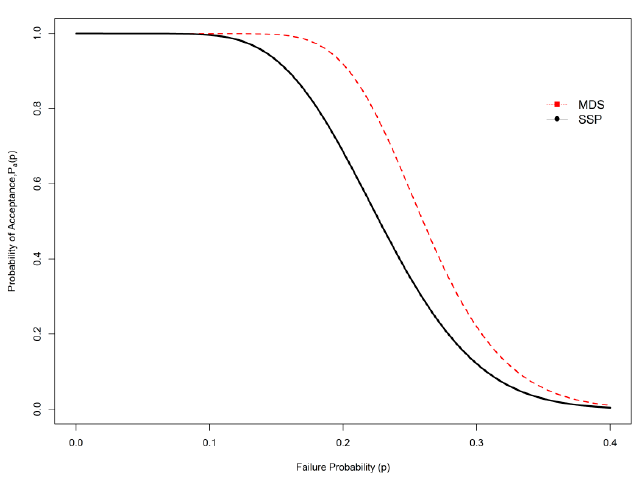
Figure 2. OC curve comparison between SSP and MDS under indeterminacy.